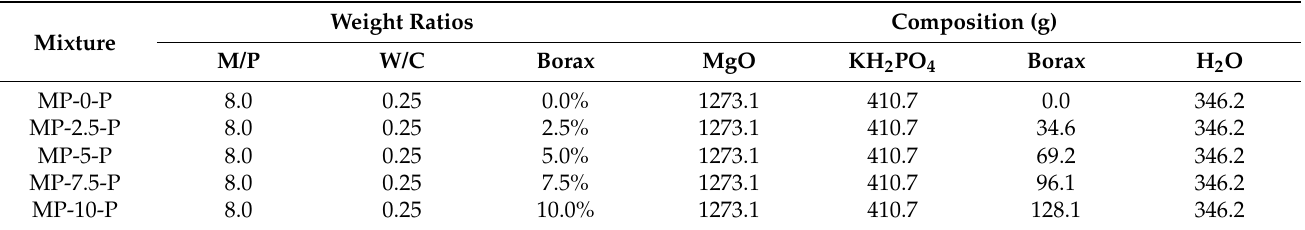
Table 3. Mix proportion of MKPC